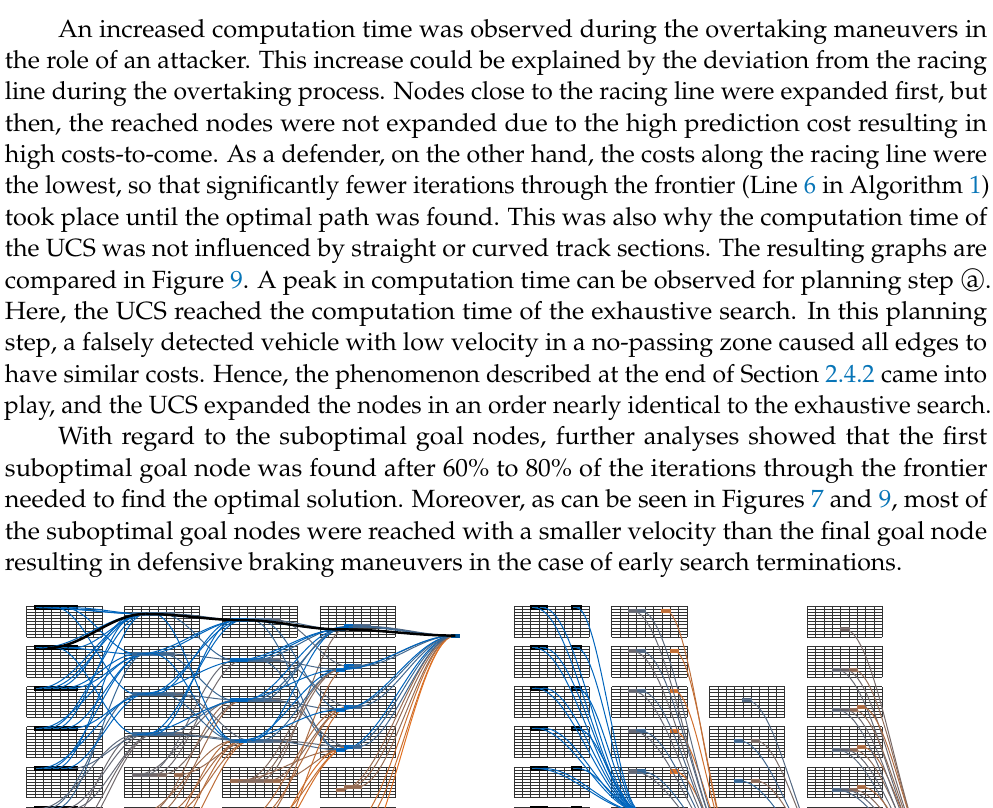
Figure 8. Comparison of computation times. The planning steps of the considered race section were recalculated with the UCS and the exhaustive search. The black-dotted line shows the actual computation times for the UCS on Dallara AV-21 hardware during the race. The defending and attacking maneuvers are highlighted.